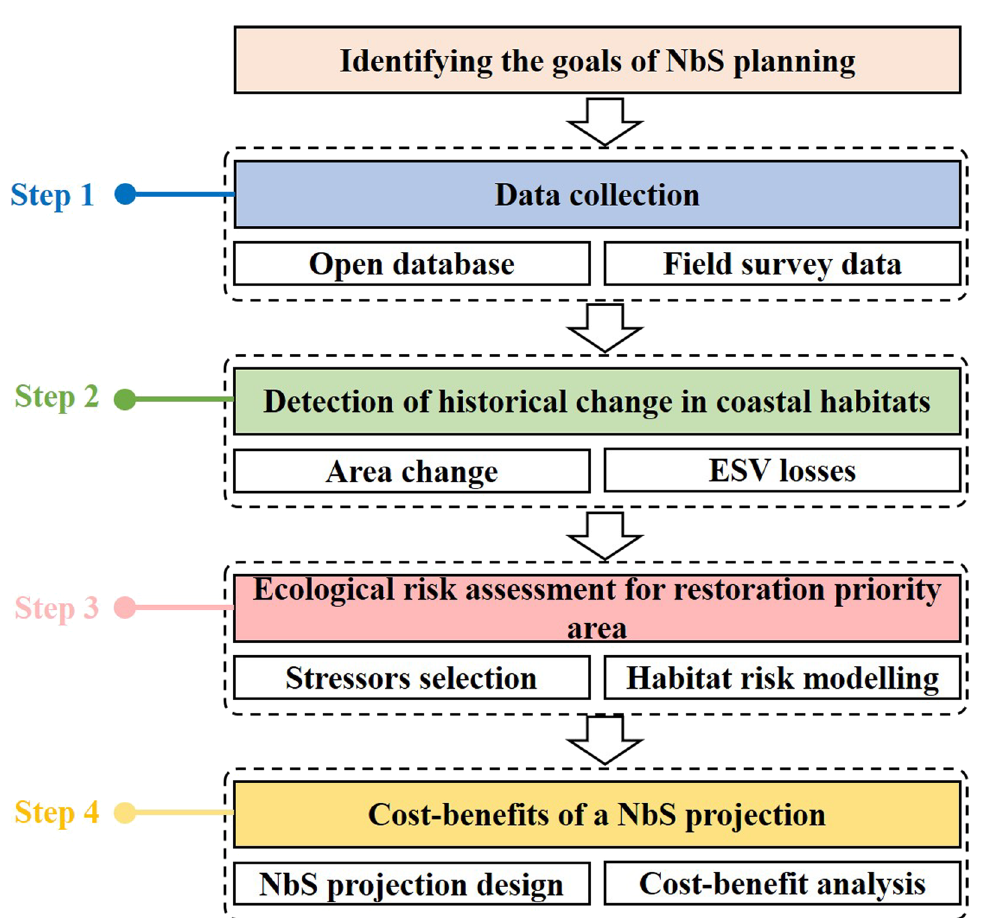
Fig. 2 Conceptual framework of the research methods. NbS: nature-based solution, ESV: ecosystem services